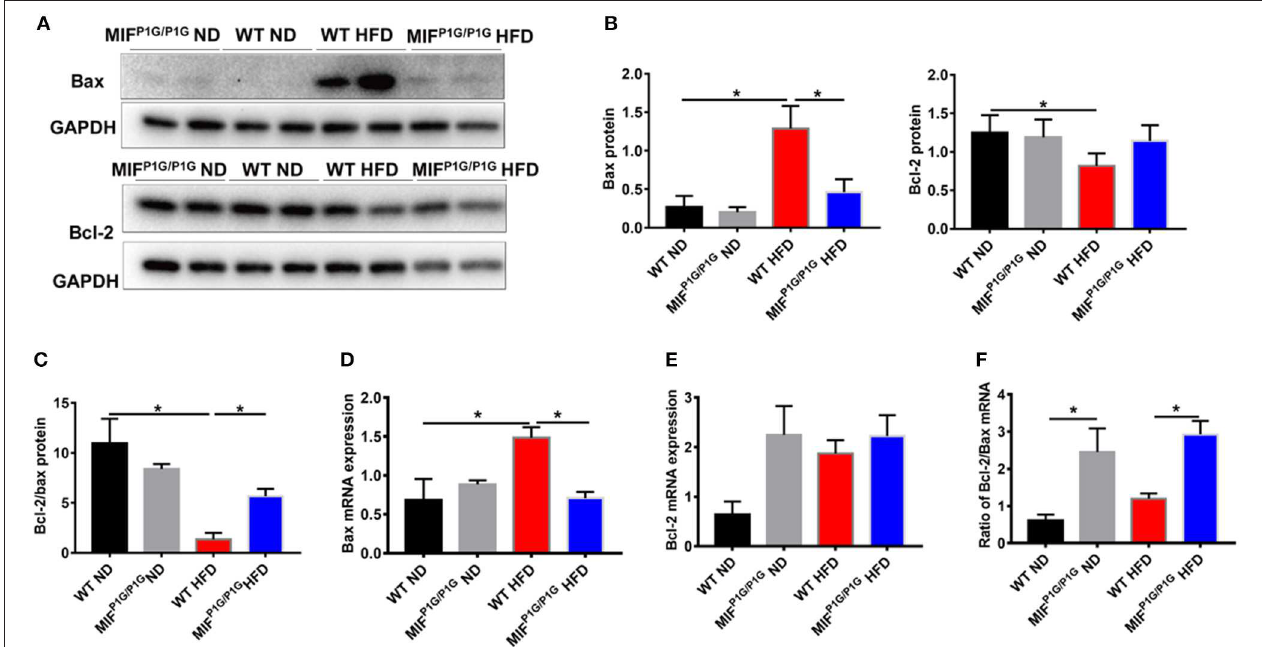
FIGURE 5 | MIF P1G / P1G mice ameliorated adipocyte apoptosis under HFD. (A) The images of Bax and Bcl2 protein by Western blot analysis in adipose tissue from WT and MIF P1G / P1G mice fed ND or HFD. (B) The quantitative analysis of the protein level of the Bax and Bcl2 was determined in adipose tissue from WT and MIF P1G / P1G mice fed ND or HFD. (C) The ratio of Bcl2/bax in protein level was quantitatively determined in adipose tissue from the two group mice. (D–E) The expression of Bax and Bcl2 by real-time PCR analysis in adipose tissue from the two group mice. (F) The ratio of Bcl2/Bax was quantitatively determined by qPCR in adipose tissue from the two group mice. Data are shown as mean ± SEM, * p < 0.05, n = 4–5 per